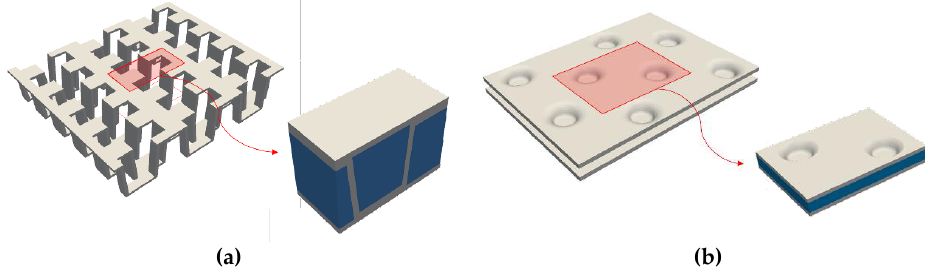
Figure 2. Definition of the representative elementary volume (REV) model adopted for the characterization of the fluid dynamics and heat transfer properties of the turbulator structure: ( a ) Offset-strip fins and ( b )